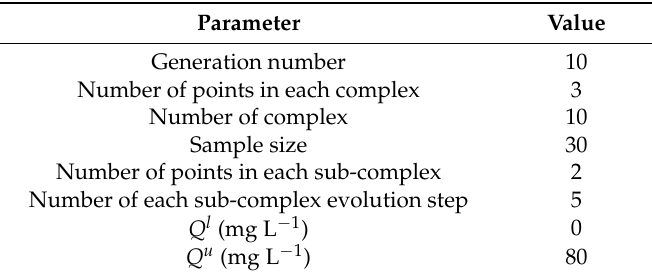
Table 3. Input control parameters of SCE-UA algorithm.